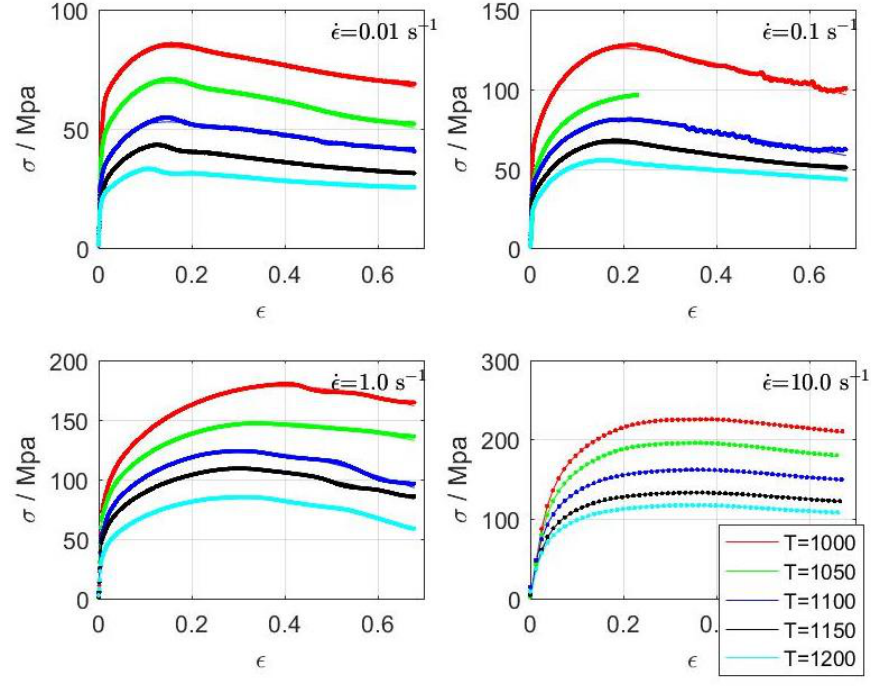
Figure 1. Tightly matching measured and calculated true stress vs. true strain curves for temperatures (1000, 1050, 1100, 1150, and 1200 °C) and strain rates (0.01, 0.1, 1, and 10 s −1 ).